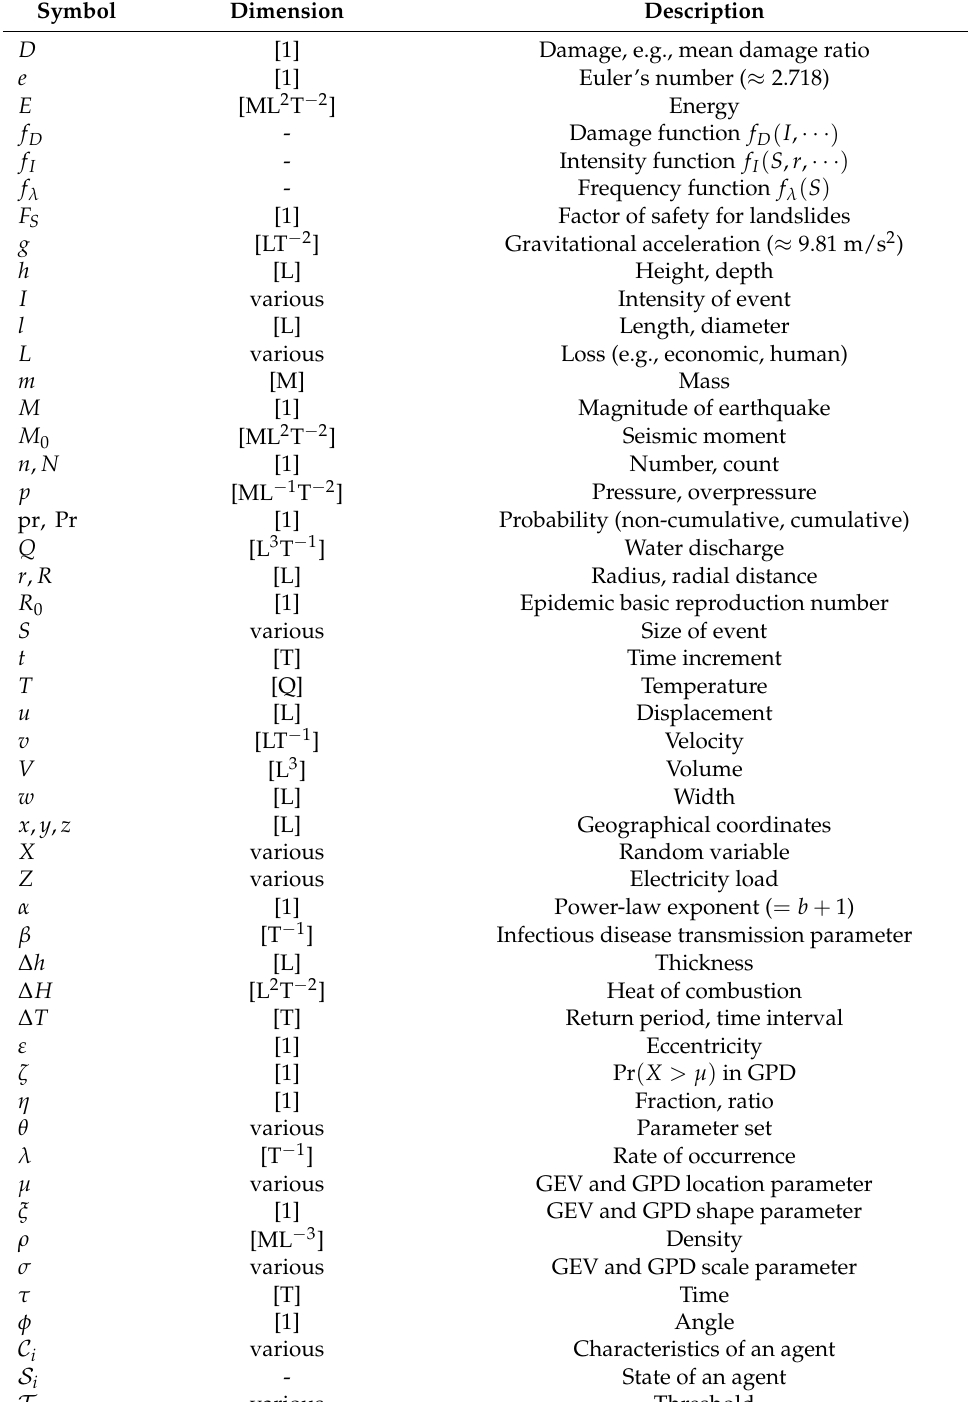
Table A1. Cont. Symbol